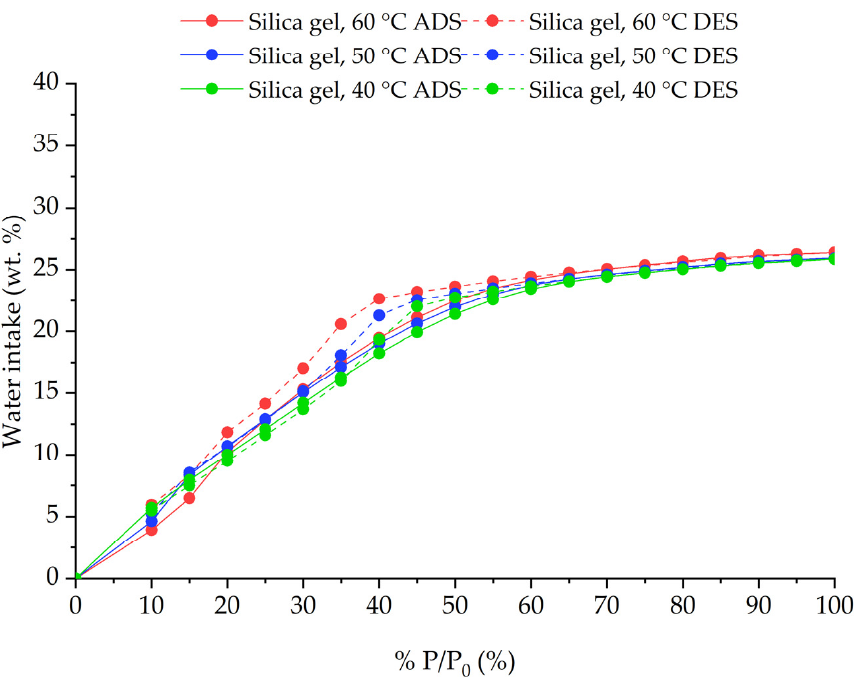
Figure 10. Adsorption and desorption isotherms for Silica gel samples, at 40, 50 and 60 °C .